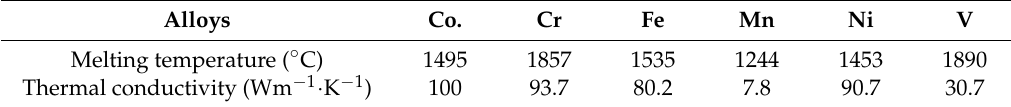
Table 2. Melting temperature ( T m ) and thermal conductivity ( k ) of chemical elements. Alloys Co. Cr Fe Mn Ni V Melting temperature ( ◦ C)